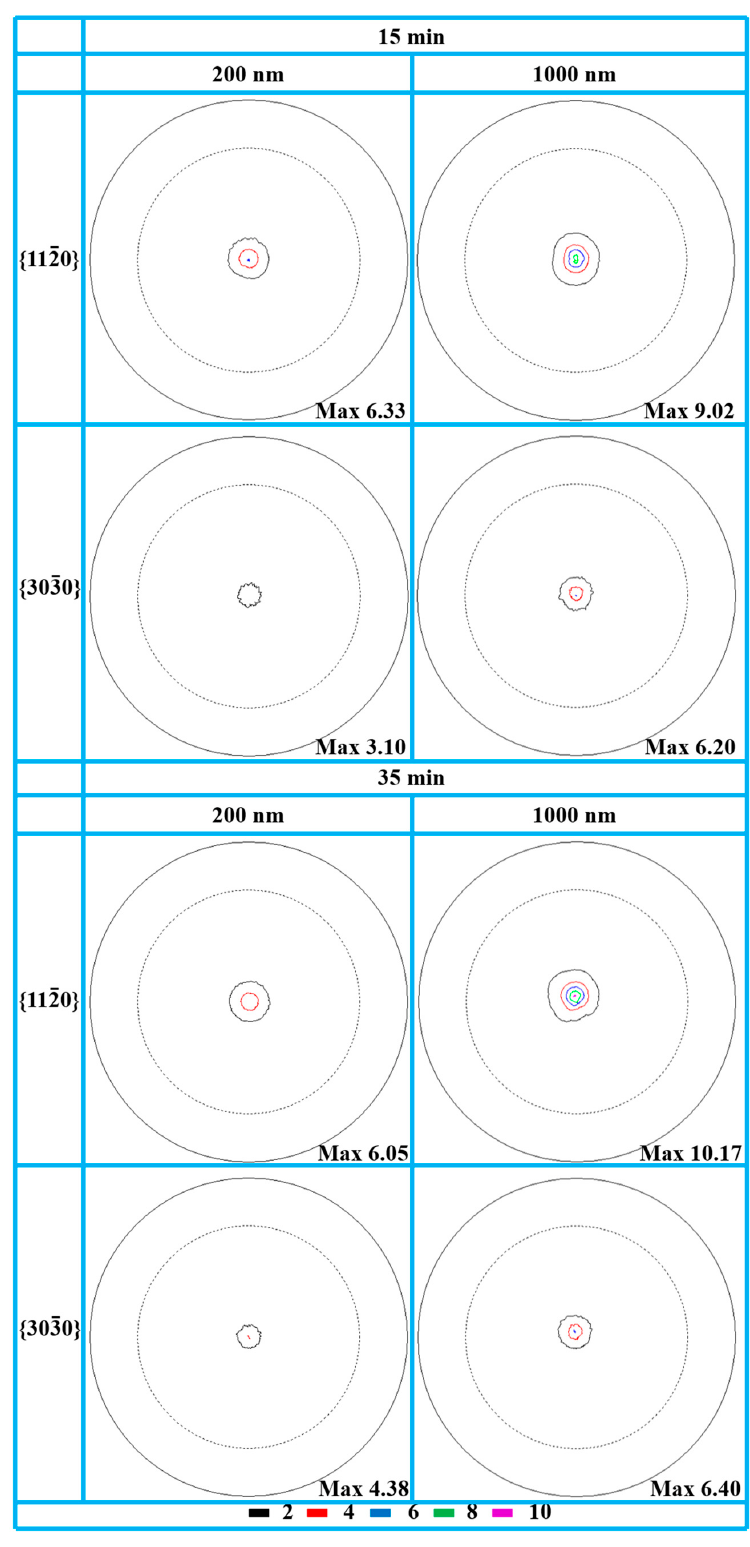
Figure 7. Measured 1120 and 3030 PFs of 200 nm and 1000 nm Sb 2 Te thin films annealed at 15 min (top panel) and 35 min (bottom panel). Different colors represent pole density levels: black for 2, red for 4, blue for 6, green for 8, and lavender for 10. The maximum pole density is near the center of the measured PFs.